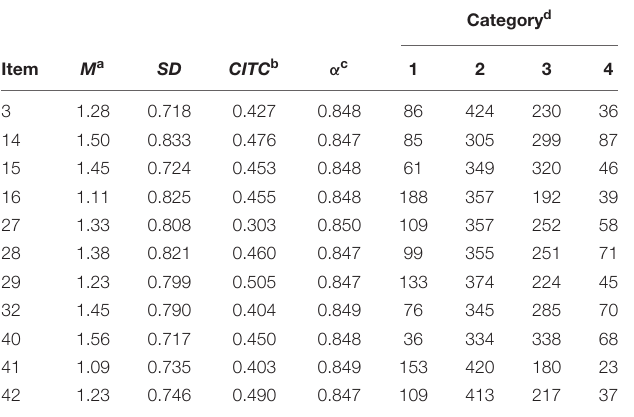
TABLE 3 | Classical item analysis of self-efficacy for self-regulated learning scale ( α = 0.87, CI 95 = 0.85,